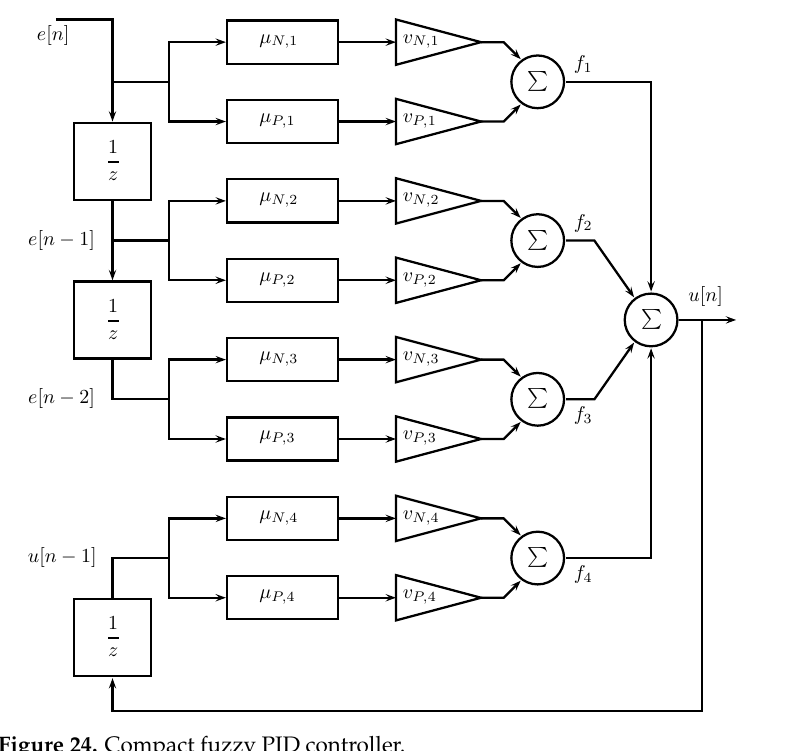
Figure 24. Compact fuzzy PID controller.